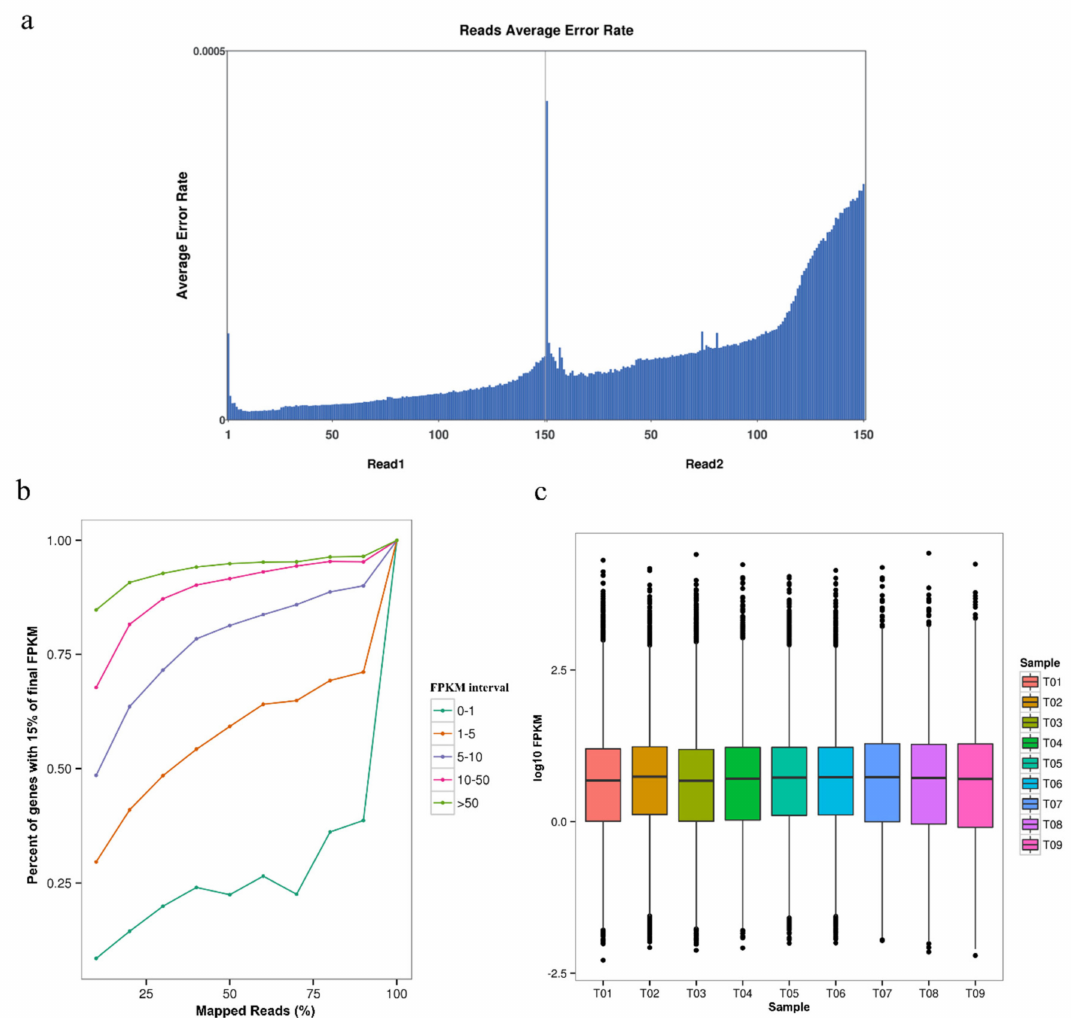
Figure 2. Evaluation of sequencing quality and expression. ( a ): Distribution of sequencing error rate. Read 1 and read 2 are paired-end sequencing reads generated from Illumina platform. ( b ): Saturation diagram of transcriptome data. The abscissa represents the percentage of reads located on the genome from sampling data to the total mapping rate, and the ordinate represents the percentage of genes in each fragment per kilobase of transcript per million fragments mapped (FPKM) range whose expression difference is less than 15% in all sampling results. ( c ): Box plot of FPKM values in each sample. The black solid line in the boxplot represented the average FPKM values. T01, T02, and T03, respectively, represent one female and two male trees at period 1 (18 June), and T04-T06/T07-T09 represent these three trees at period 2 (15 August) and period 3 (15 October)